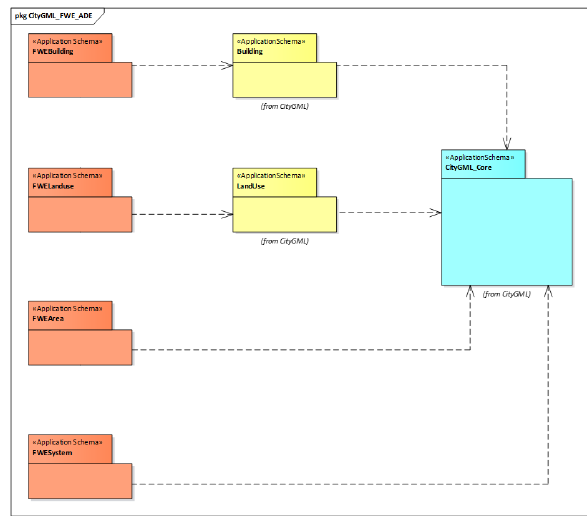
Figure 3. The UML package diagram for the FWE ADE